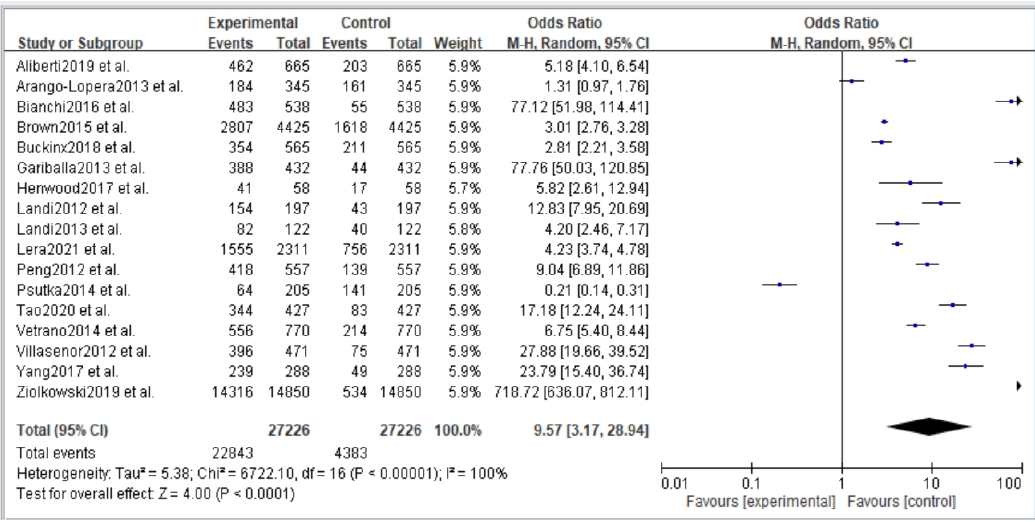
Figure 6. Summary estimates for the sarcopenia status compared to mortality outcome.